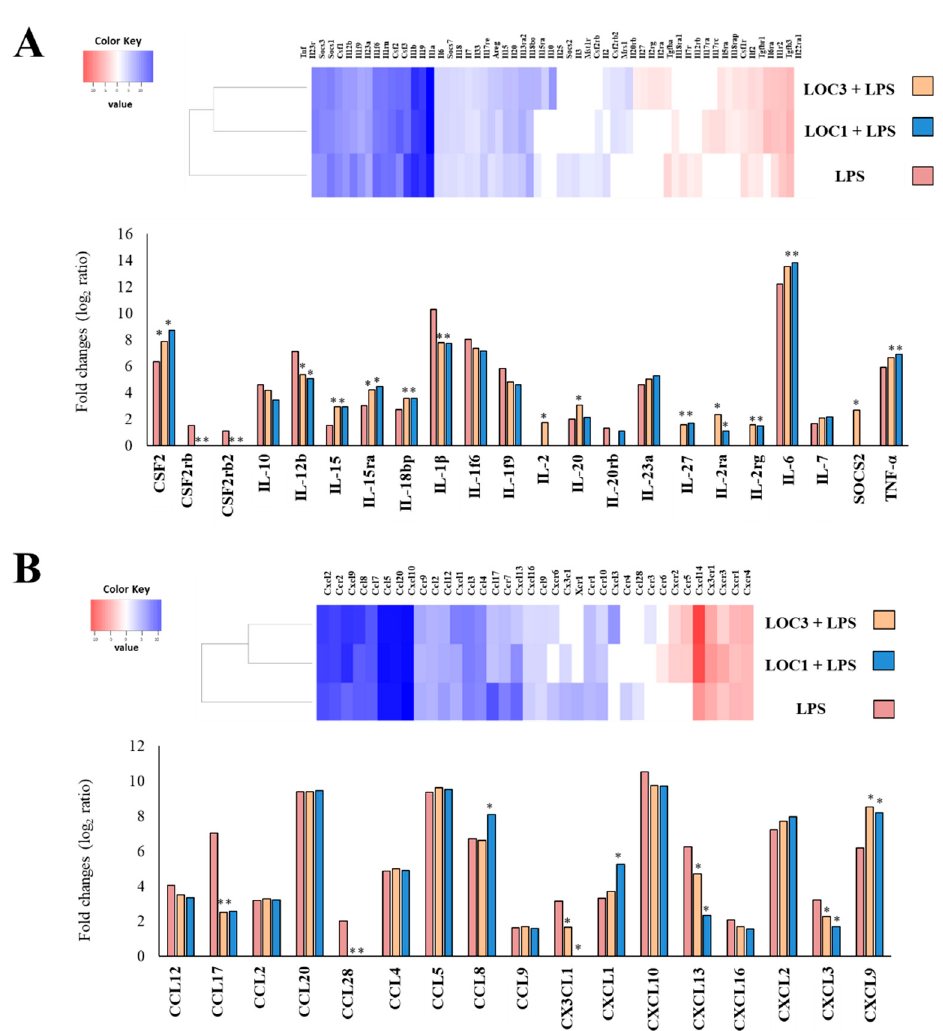
Figure 3. Effect of Lactiplantibacillus plantarum strains isolated from fresh tea leaves in murine RAW macrophages stimulated with the Toll-like receptor 4 (TLR4) agonist lipopolysaccharide (LPS). Macrophages were treated with L. plantarum LOC1 or LOC3 strains and then challenged with LPS. The expression of genes was determined by microarray analysis 3 h after LPS stimulation. Non-lactobacilli-treated macrophages stimulated with LPS were used as control. Heat-map analysis and fold expression changes of cytokines ( A ) and chemokines ( B ). Asterisks indicate significant differences between the indicated groups and LPS-challenged control macrophages, (*) p < 0.05.